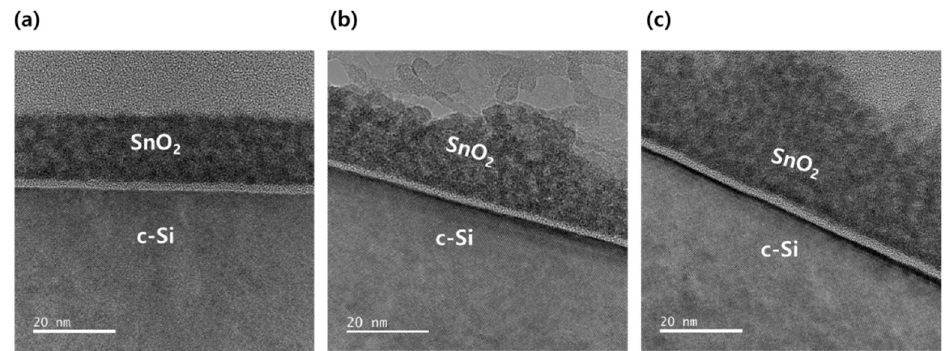
Figure 3. Transmission electron microscopy (TEM) analysis of the Si/SnO 2 interface under various conditions: ( a ) spin-coating tin oxide (SnO 2 ) and ( b ) chemical bath deposition (CBD) at 4 h and ( c ) 8 h.